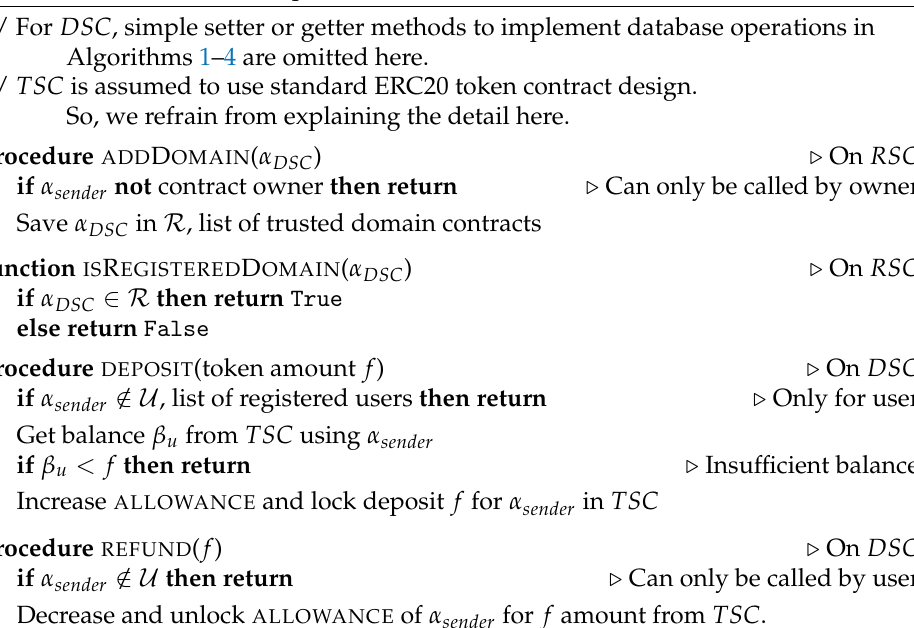
Algorithm 5 The smart contract pseudocode.